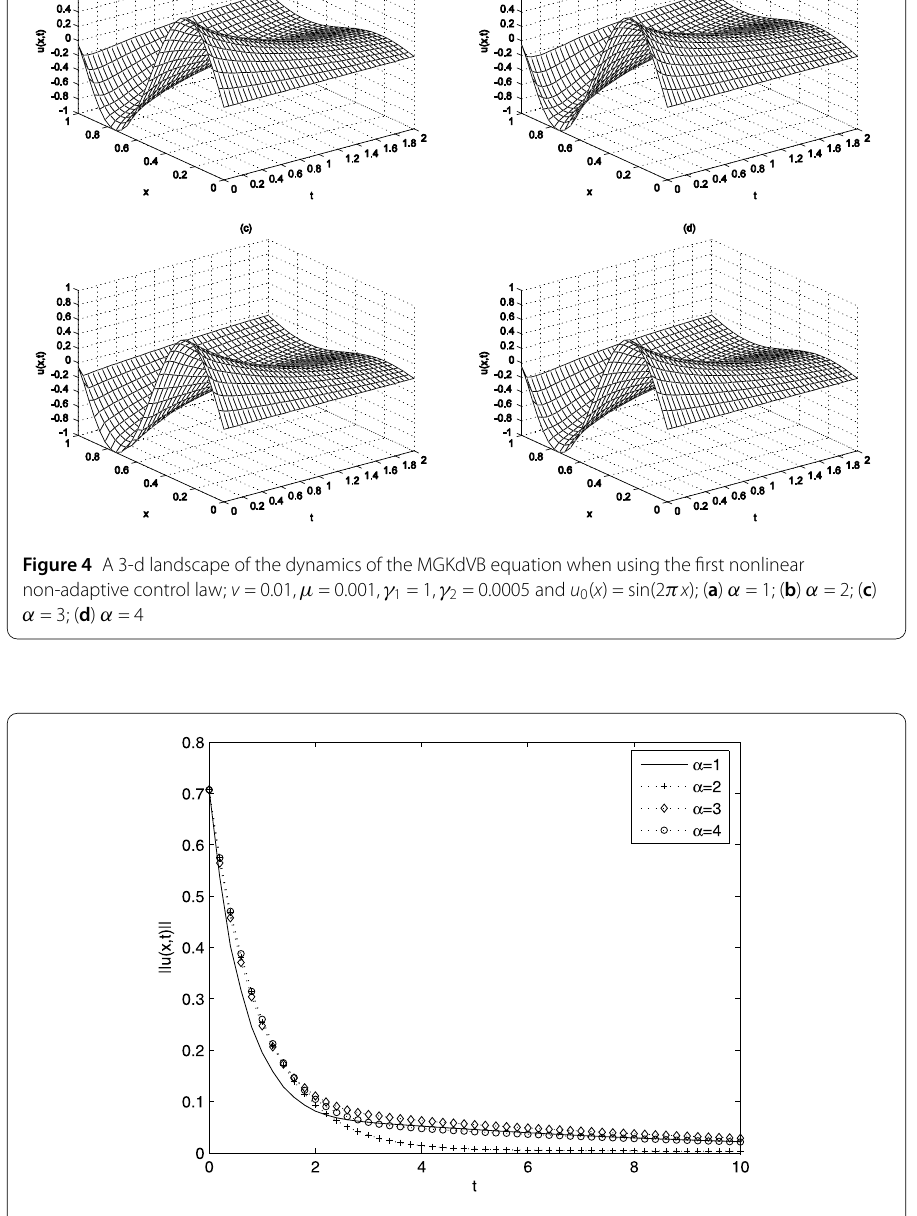
Figure 5 The L 2 -norm of u ( x , t ), (cid:7) u ( x , t ) (cid:7) , versus time for various values of α when using the first nonlinear non-adaptive control law; v = 0.01, μ = 0.001, γ 1 , γ 2 = 0.0005 and u 0 ( x ) = sin(2 π x